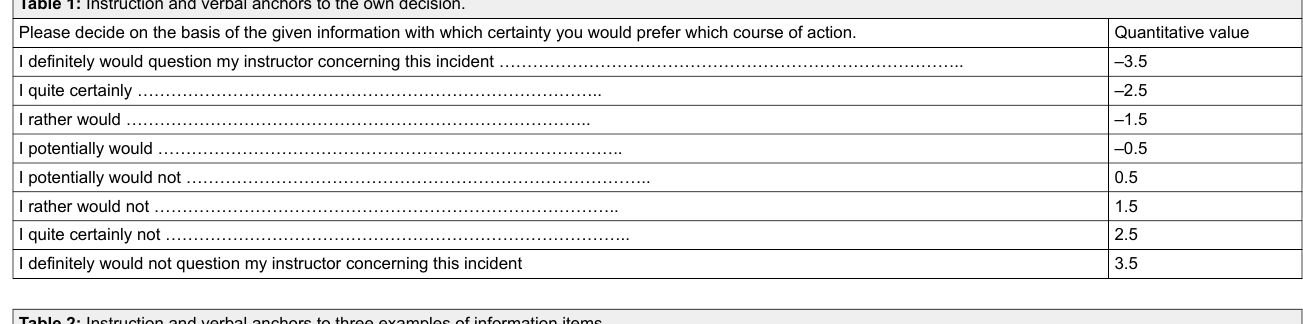
Table 2: Instruction and verbal anchors to three examples of information items. How high should the psychotherapy apprentice, from your point of view, value the single and isolated* units of information for or against confronting the instructor? (*If no other argument militates for or against the action.) Example items: Argues